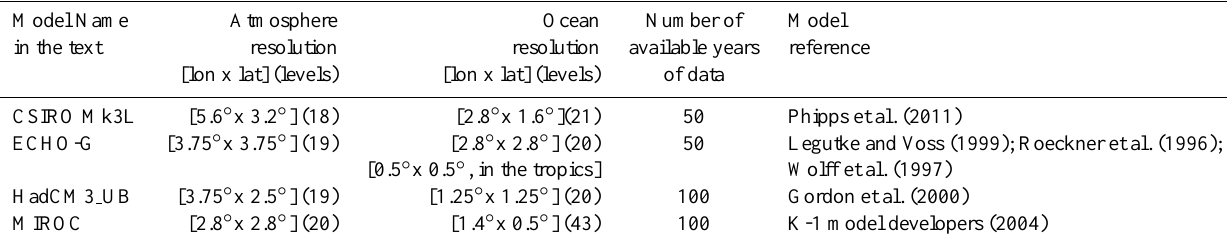
Table 1. Characteristics of the models used in this study.